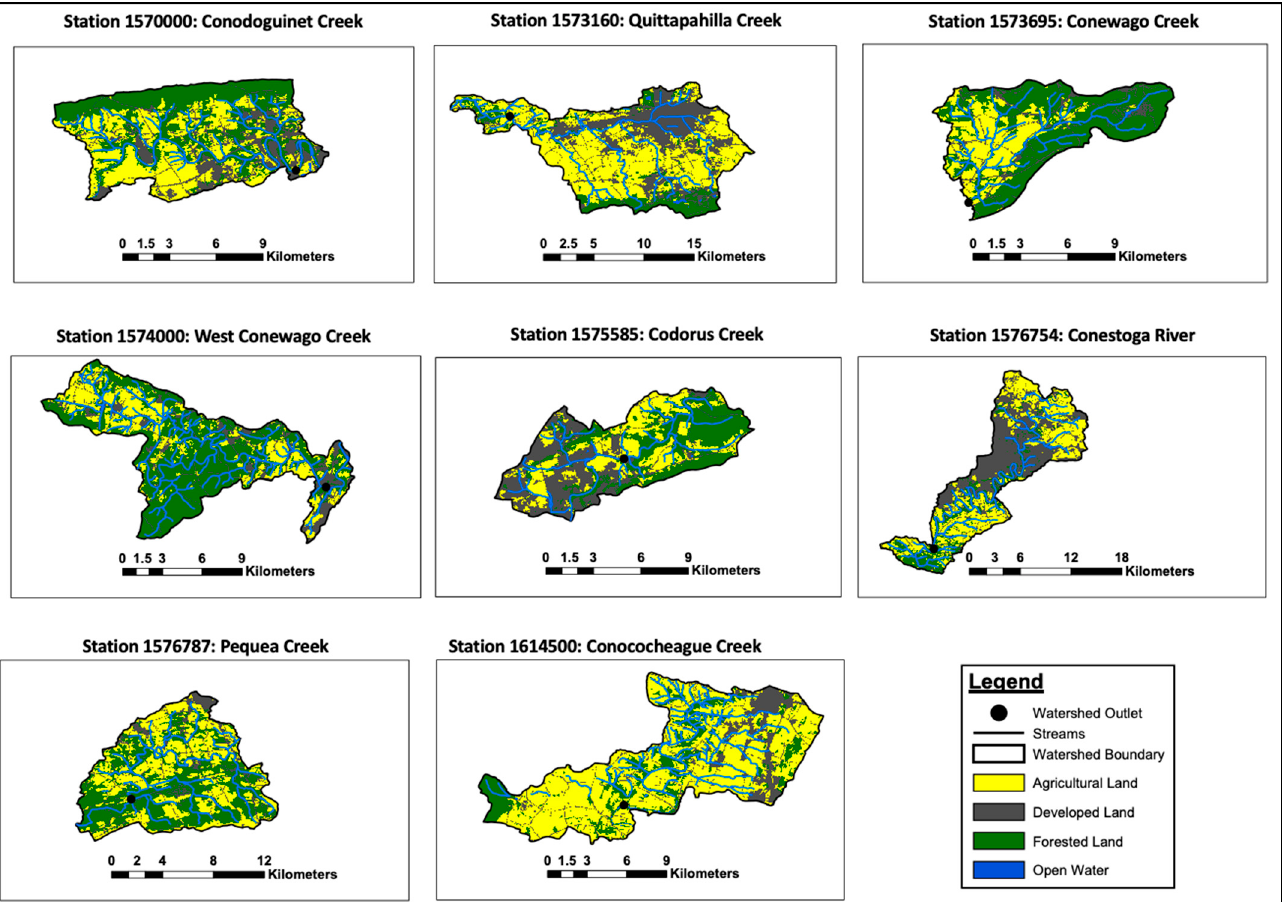
Figure 1. Land-use composition of the eight selected study site in the Pennsylvania portion of the Chesapeake Bay watershed. Base layer for the maps is the USGS 2016 National Land Cover Data (Available at: https://www.mrlc.gov/national-land-cover-database-nlcd-2016; accessed on 30 June 2020).